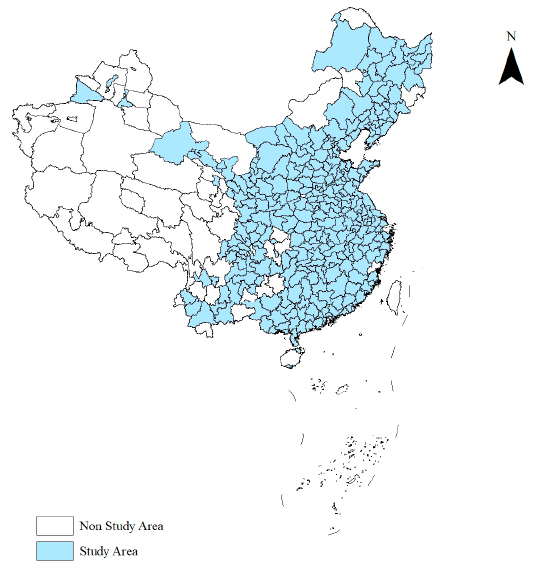
Figure 2. Study area